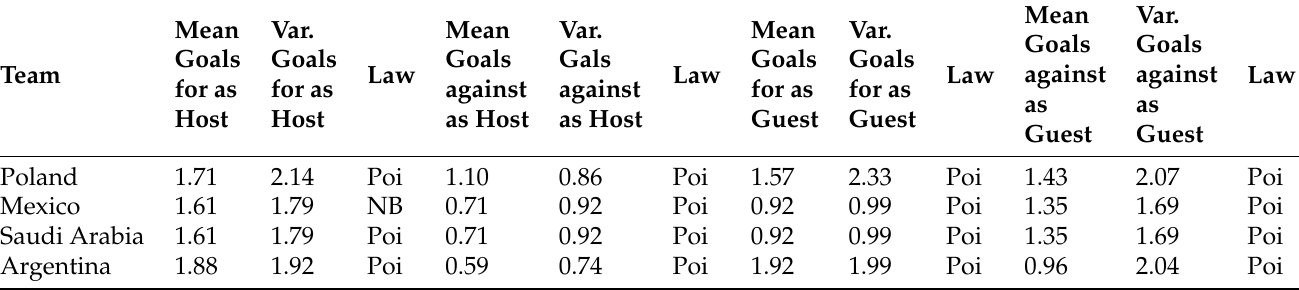
Table 21. Group C in Qatar 2022.